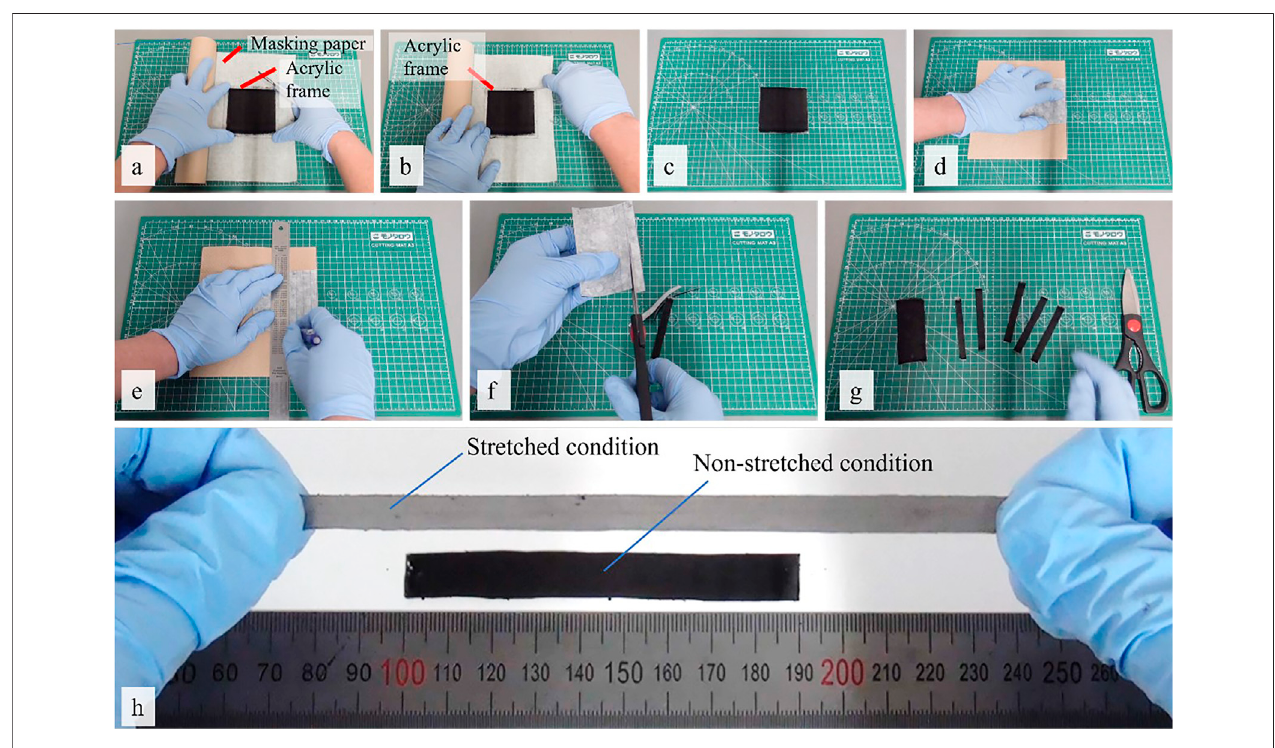
FIGURE 3 | Shaping process of the stretchable strain